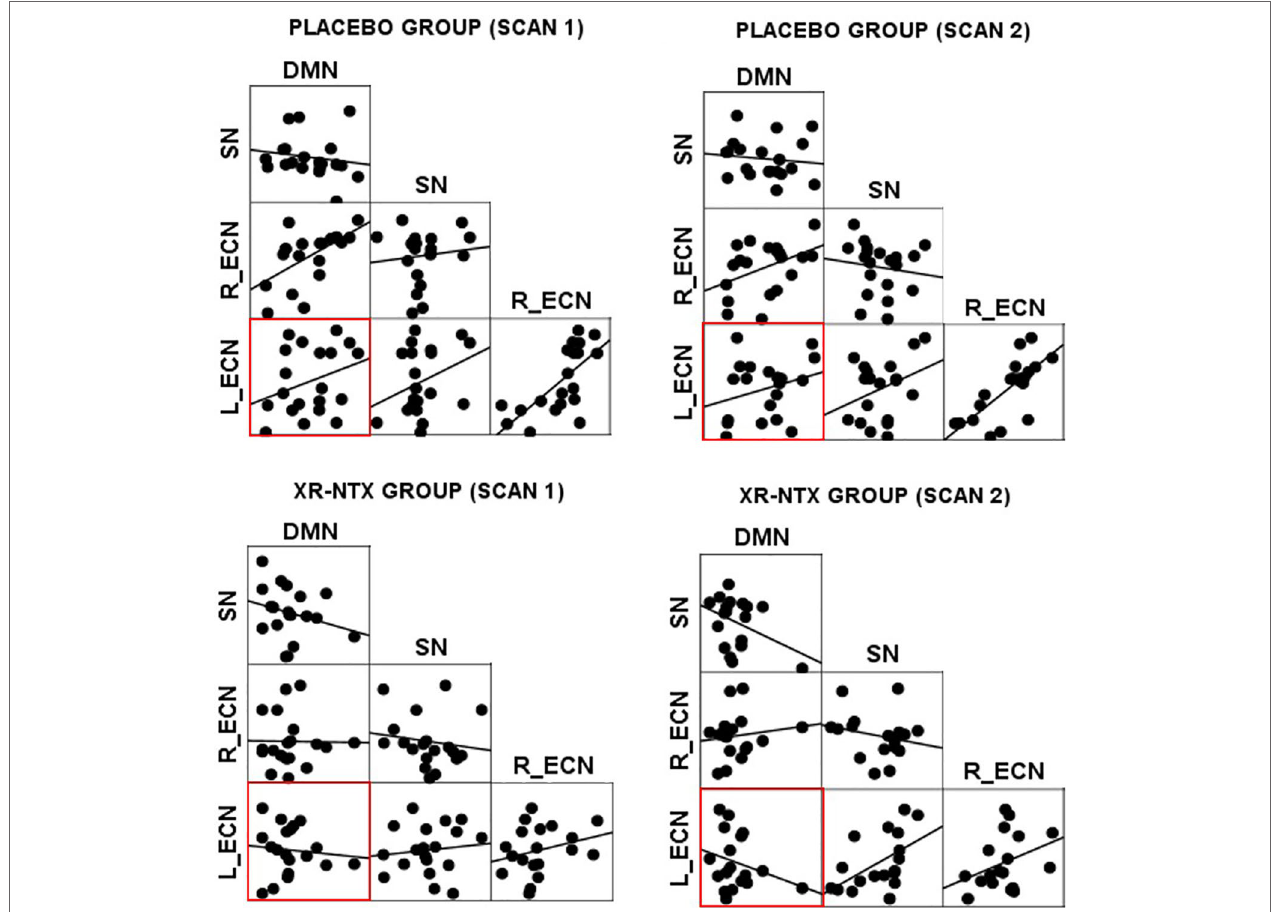
FIGURE 2 | Network correlations. Scatter plots depict the relationships between networks in each group for each scan.